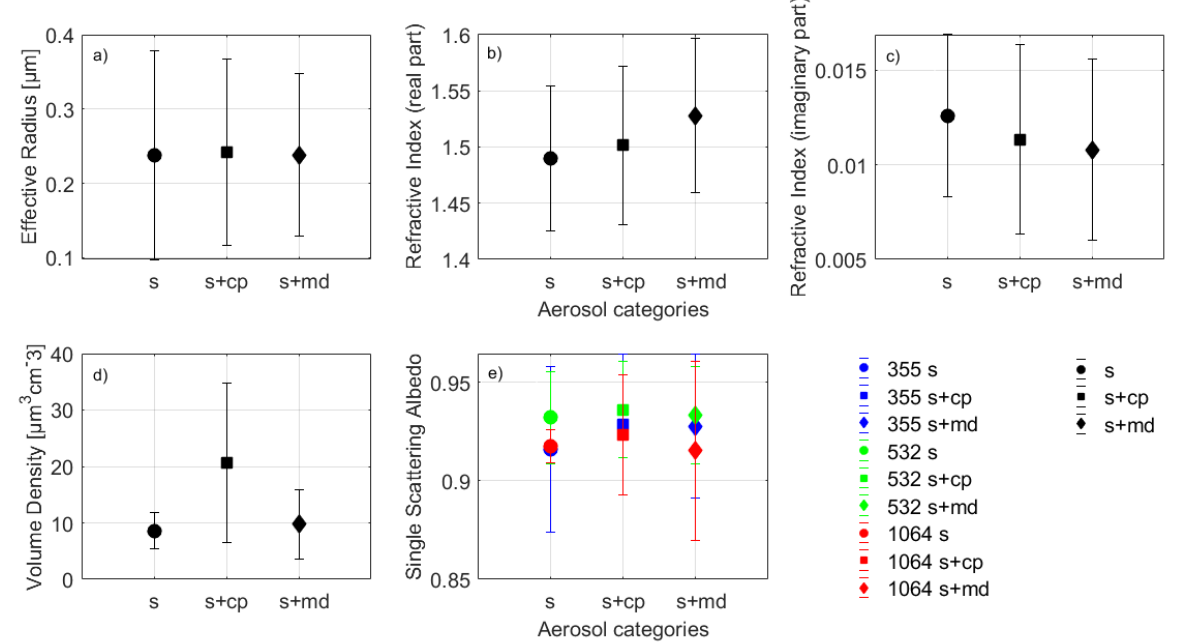
Figure 4. Mean aerosol microphysical properties: ( a ) effective Radius ( µ m); ( b ) real part of refractive index; ( c ) imaginary part of refractive index; ( d ) volume density ( µ m 3 cm − 3 ), and ( e ) single scattering albedo in 355 nm (blue), 532 nm (green), and 1064 nm (red) for the s (circle), s+cp (square), and s+md (diamond) aerosol categories.